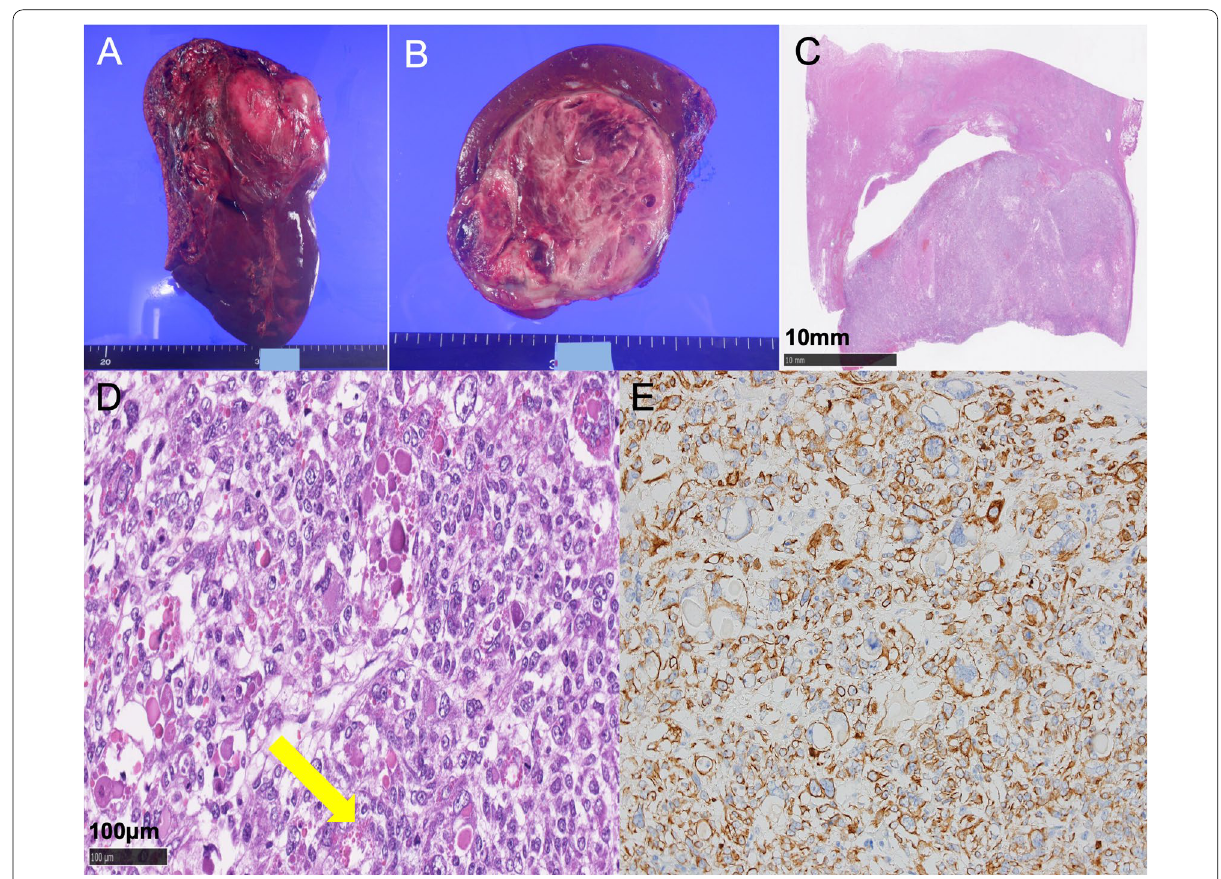
Fig. 2 Postoperative specimen findings. A , B Macroscopic findings of the surgical specimen. C , D Microscopic findings. C HE: and D HE: 200 (bar, 100 μm). Cells with granular vesicles positive for PAS were scattered in the cytoplasm (yellow arrow). E Immunohistochemical × analyses.